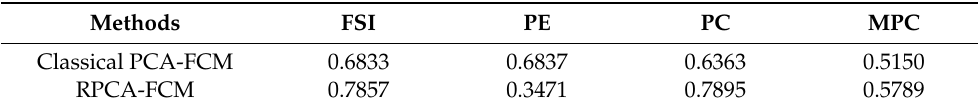
Table 6. Validity measures of the statistical models for original data.